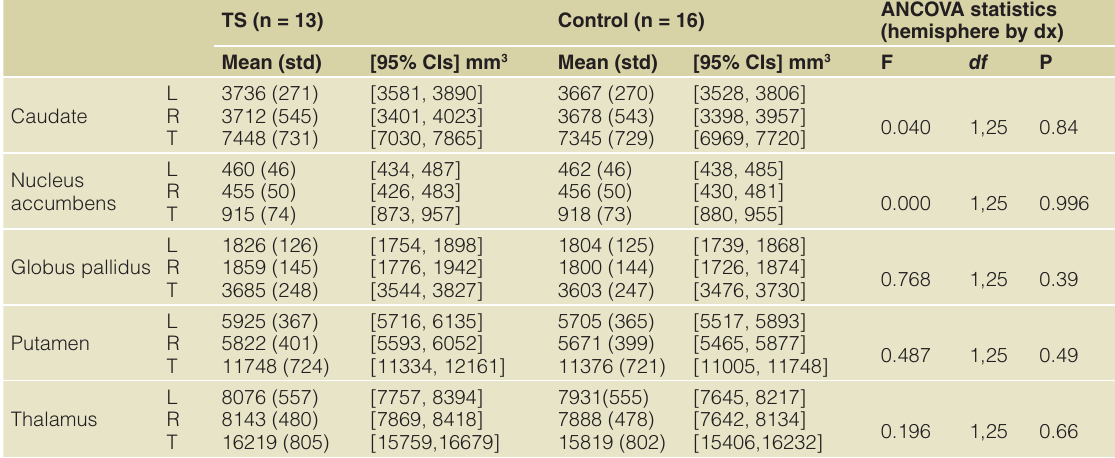
Table 2. Volumes of the structures of interest (mm 3 ).